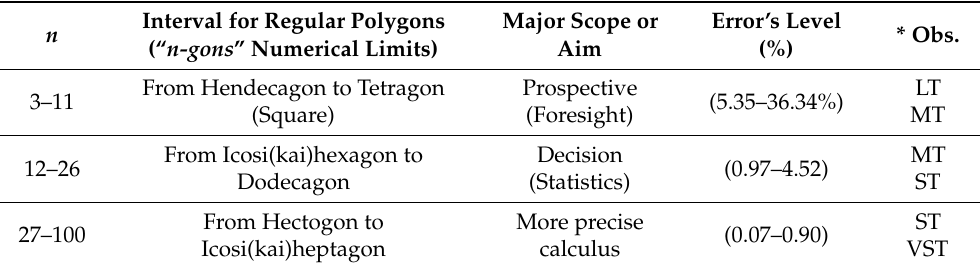
Table 7. A synthetic list of optimal intervals for “ n-gons ” GAIN based on error levels